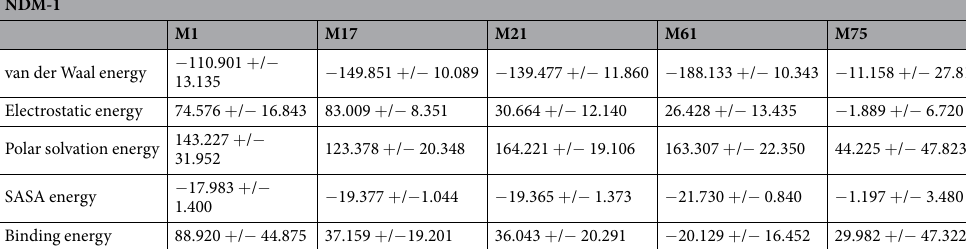
Table 3. Binding free energy of selected ligands against NDM-1 protein.